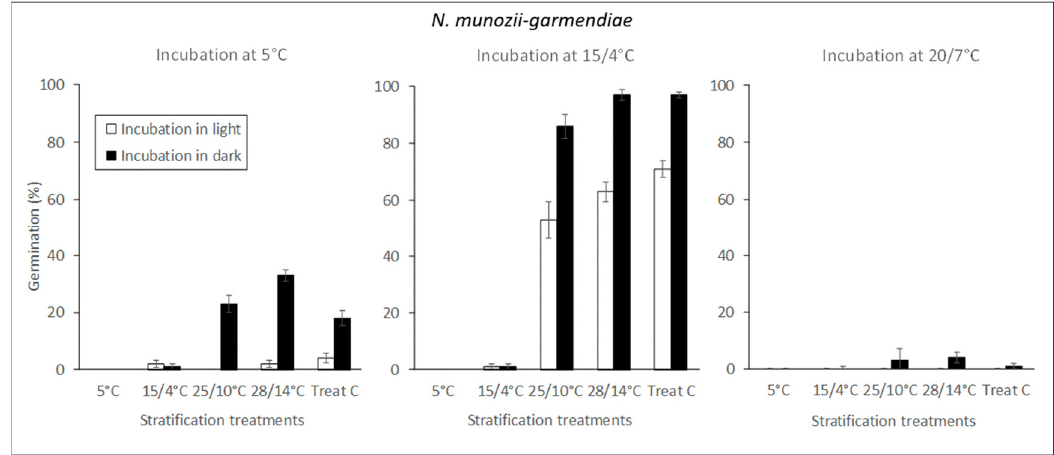
Figure 4. Germination percentages (mean ± standard error, standard error > 2%) for N. munozii- Germination percentages (mean ± standard error, standard error > 2%) for garmendiae seeds at different incubation temperatures (5, 15/4, and 20/7 °C) following different 90-day N. munozii-garmendiae seeds at di ff erent incubation temperatures (5, 15 / 4, and 20 / 7 ◦ C) following stratifications (5, 15/4, 25/10, 28/14 °C, and treatment C). White and black bars denote the germination di ff erent 90-day stratifications (5, 15 / 4, 25 / 10, 28 / 14 ◦ C, and treatment C). White and black bars denote percentages after incubation in the light and darkness, respectively. the germination percentages after incubation in the light and darkness,